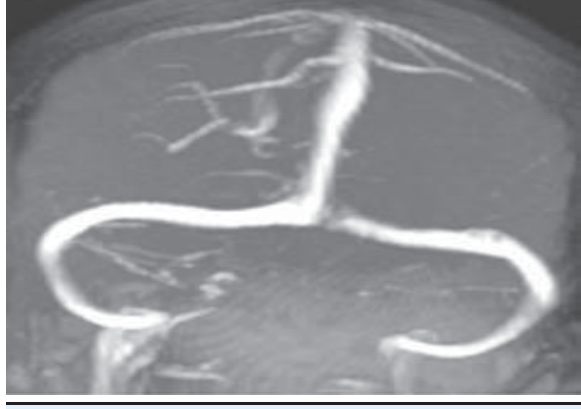
Figure 4. Codominant transverse sinuses